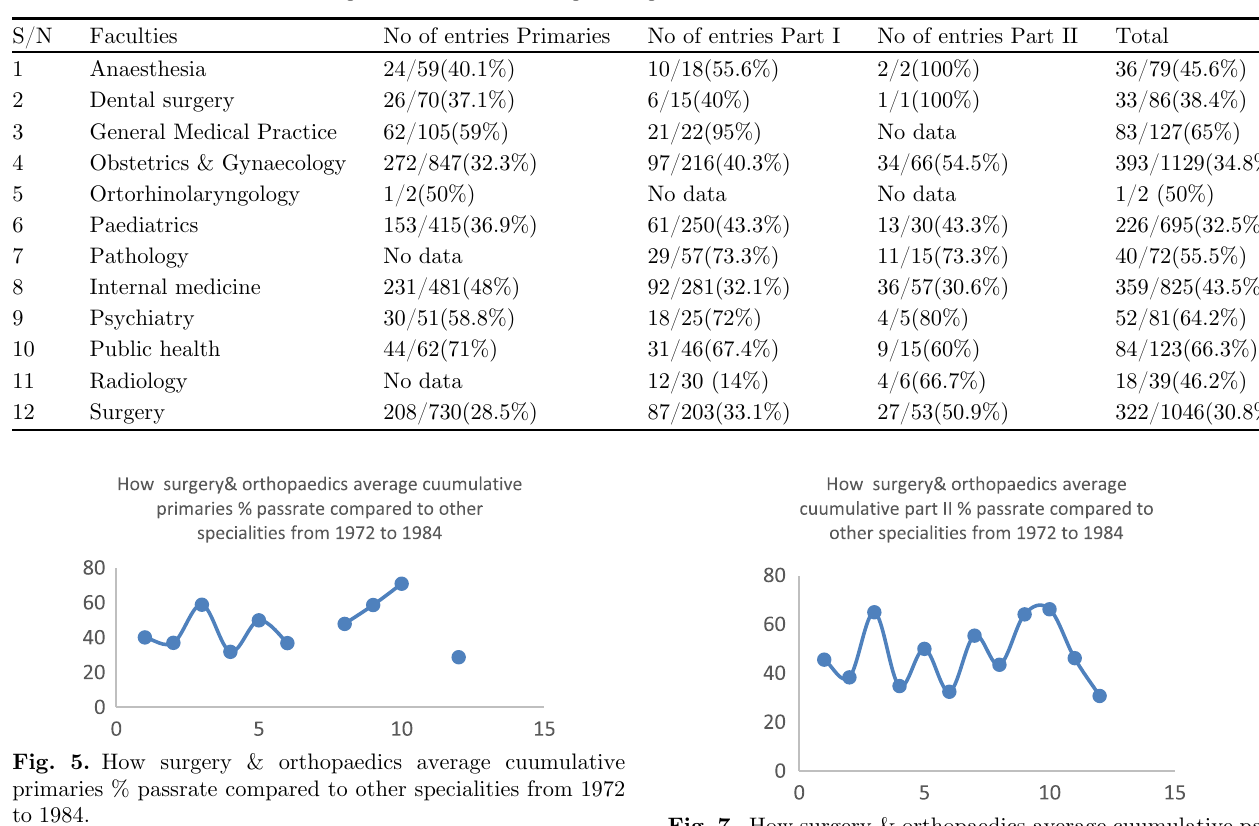
Table 2. Passrate National Postgraduate Medical College of Nigeria 1972 – 84.